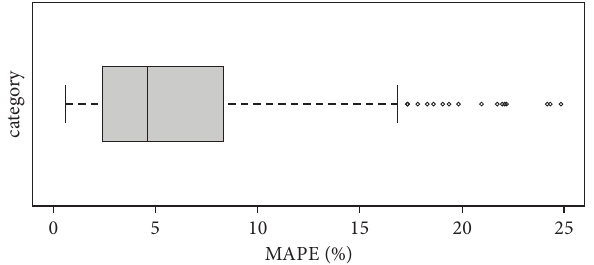
Figure 7: Mean absolute percentage error (MAPE) results at 1-hour prediction ( k � 5, lag duration � 20 min). Table 5: Prediction reliability based on mean absolute percentage error (MAPE). MAPE Prediction reliability